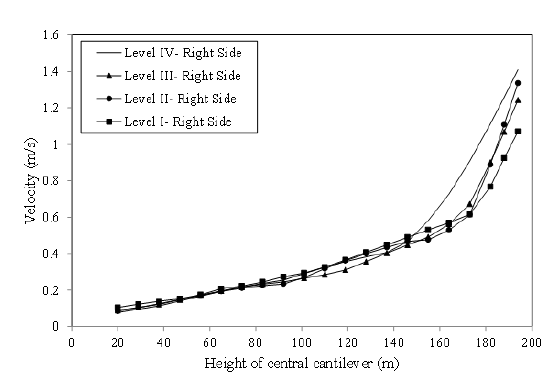
Figure 16. Non-concurrent envelope of velocity along the height of the crown cantilever; NL-DCM